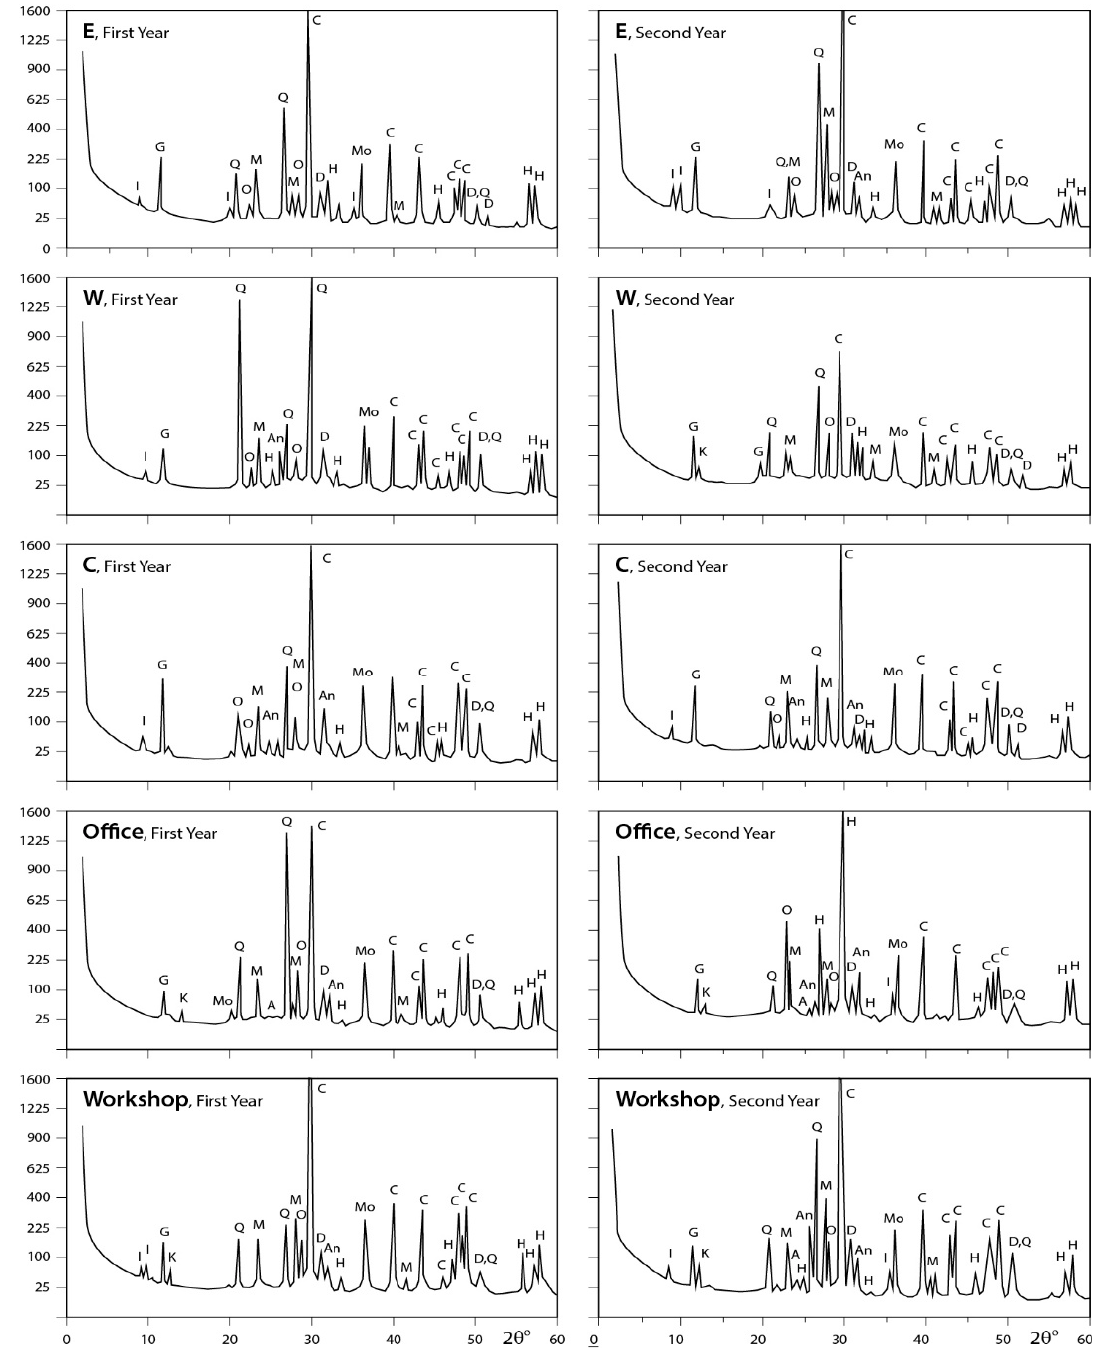
Figure 7. XRD profiles for the analyzed samples. A = albite; An = anhydrite; At = antigorite; C = calcite; D = dolomite; F = feldspar; G = gypsum; H = halite; I = illite; K = kaolinite; M = microcline; Mo = montmorilonite; Ms = muscovite; O = orthoclase; Q = quartz; T = tremolite (E, W, and C represent the different locations).